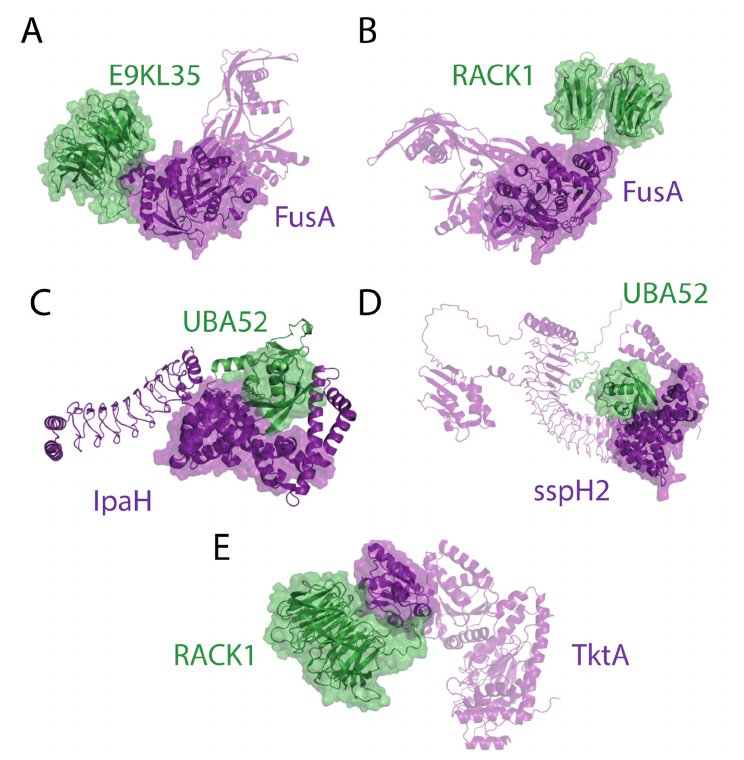
Figure 7. Domain–domain interactions predicted by Alphafold Multimer. ( A ) E9KL35-FusA; ( B ) RACK1-FusA; ( C ) UBA52-IpaH; ( D ) UBA52-sspH2; ( E ) RACK1-TktA.